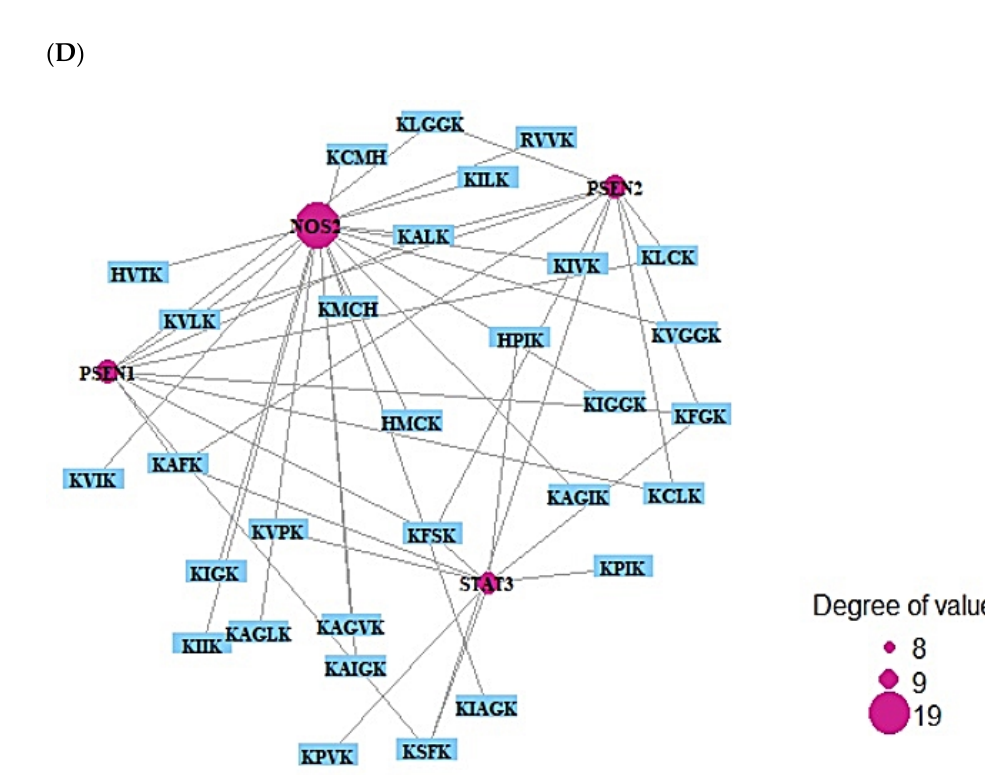
Figure 5. ( A ) The number of three signaling pathways on AMPs—AFPs’ axis. ( B ) Networks of three signaling pathways on 87 nodes (81 peptides and 6 targets) and 150 edges. ( C ) Protein–protein networks of AMPs—AFPs (6 targets). ( D ) Size map of Notch signaling pathways on NOS2, STAT3, PSEN1, and PSEN2 (34 nodes and 45 edges). Table 3. Targets in three signaling pathways’ enrichment related to AMPs ― AFPs’ axis.